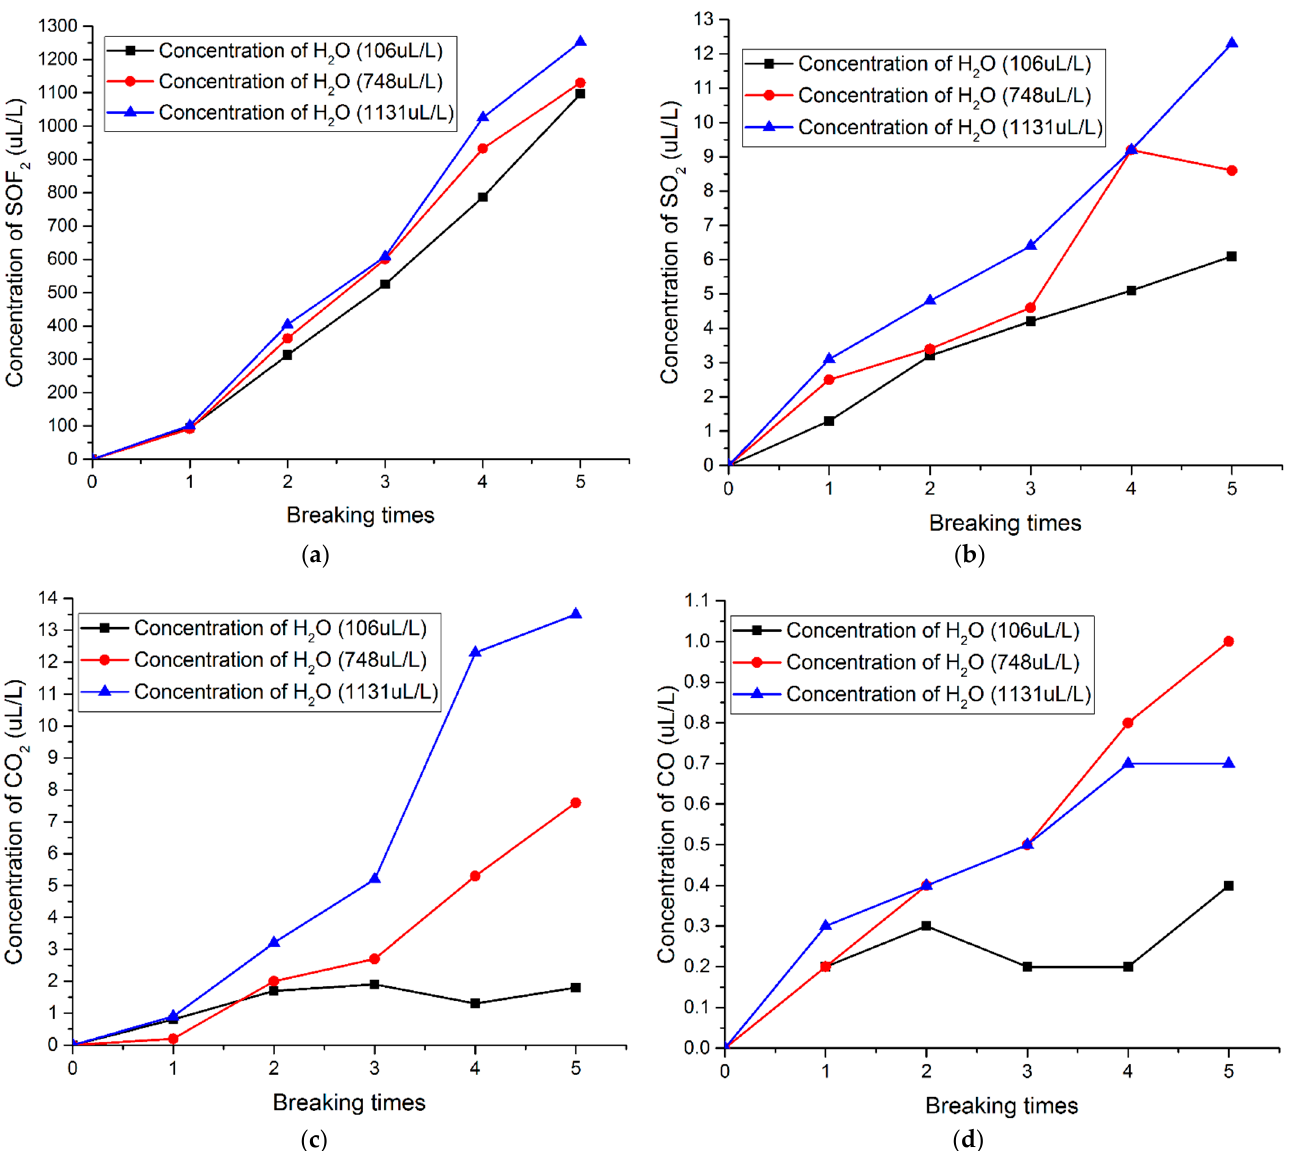
Figure 11. Changes of SOF 2 , SO 2 , CO 2 , and CO concentrations with the breaking times under different H 2 O concentration. ( a ) Changes of SOF 2 with the breaking times. ( b ) Changes of SO 2 with the breaking times. ( c ) Changes of CO 2 with the breaking times. ( d ) Changes of CO with the breaking times.